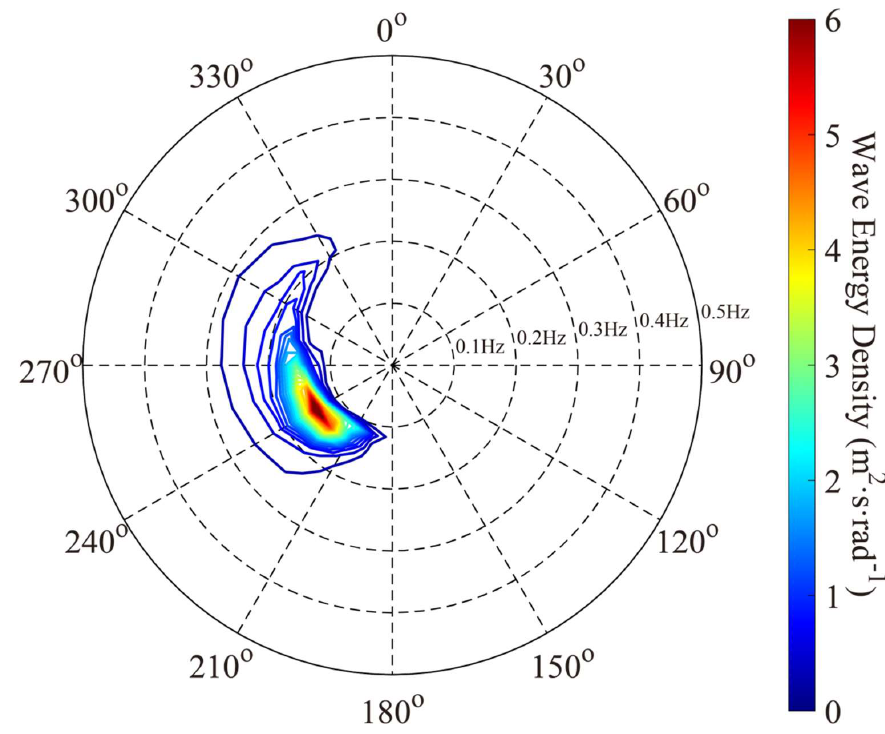
Figure 9. The wave energy density at the point (19.5° N, 107.5° E) in Typhoon Khanun at 6:00 a.m. UTC on 16 October 2017.